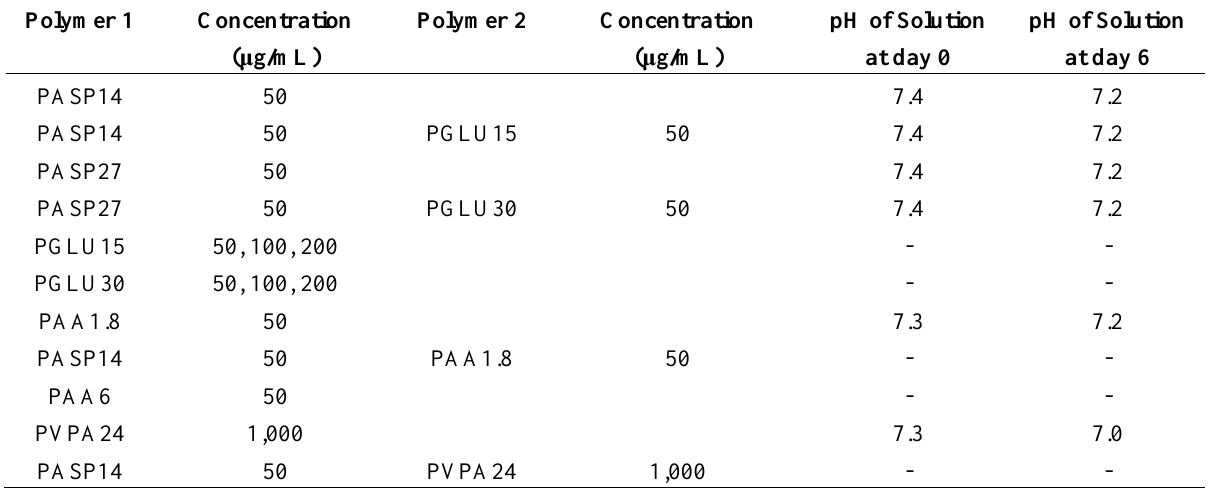
Table 1. Polymer combinations, molecular weights, and concentrations utilized in